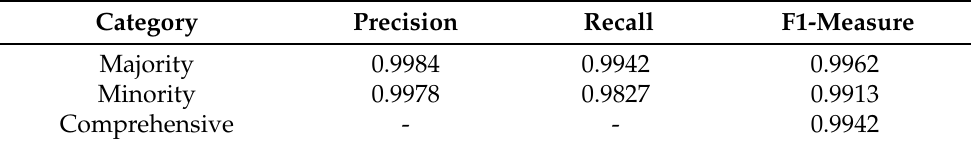
Table 6. Optimized AdaBoost performance.